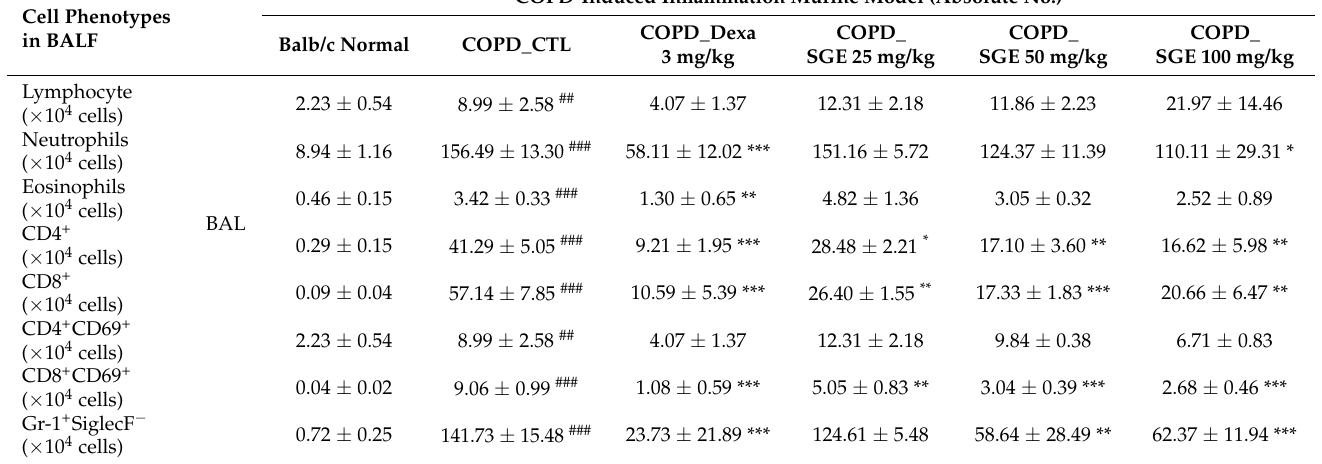
Table 1. The quantification of airway immune cell subtypes by FACS analysis in BALF from SGE- treated mice with COPD-induced inflammation.